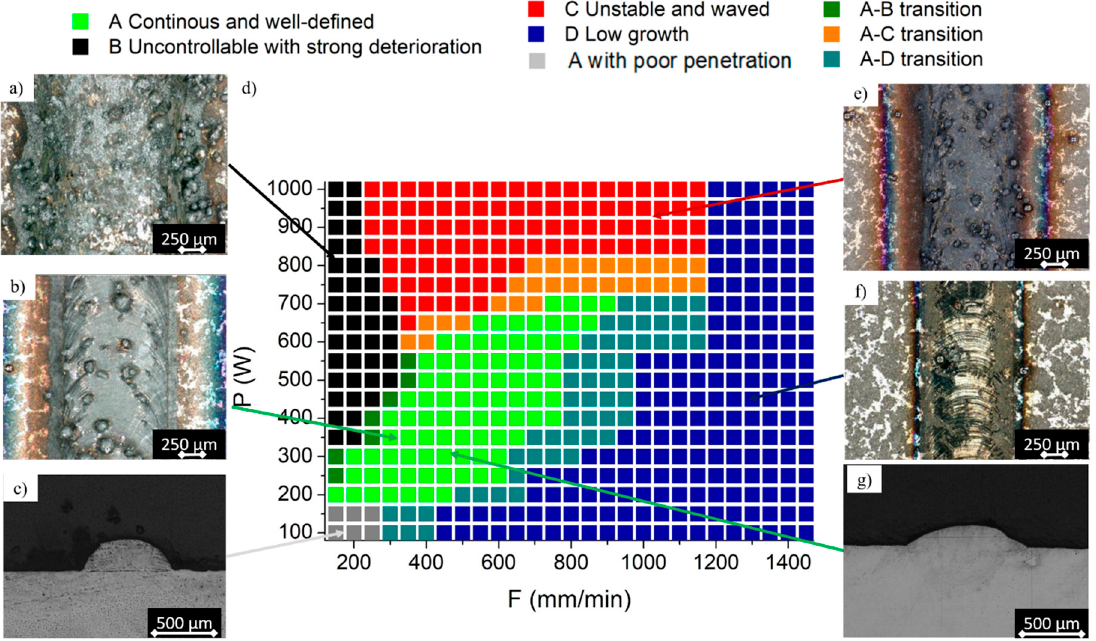
Figure 3. AISI 316L process parameter window through single tracks classification.